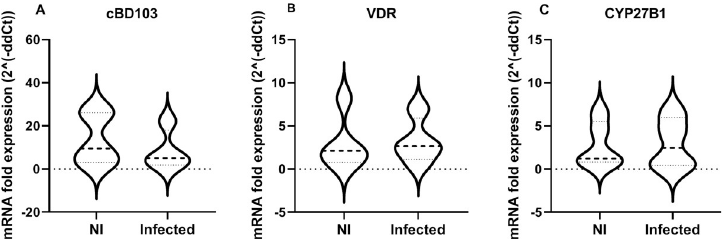
Fig 5. Expression of vitamin D pathway genes. Fold expression of CBD103 (A) CYP27B1 (B) and VDR (C) genes in Non-Infected (NI) and Infected (Infected) groups at the end of the study (T2).